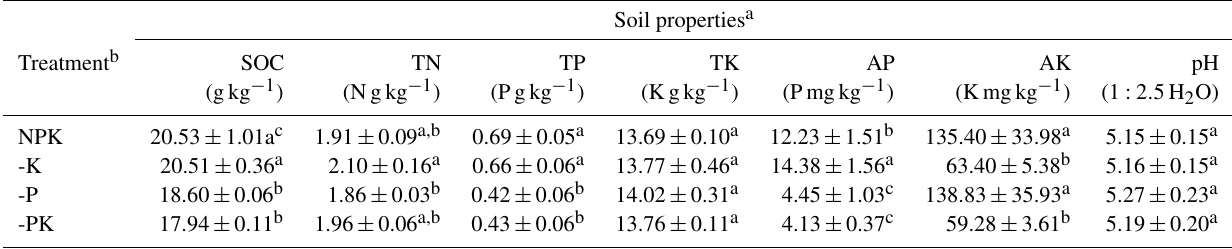
Table 1. The basic characteristics of the examined paddy soil under different fertilisation treatments at rice tillering stage and rice ripening stage.